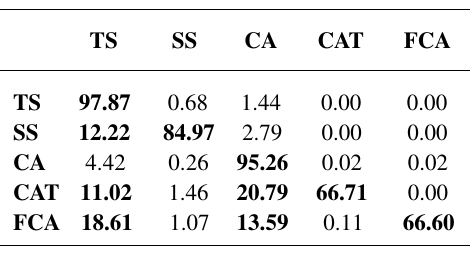
Table 14. Confusion matrix Year